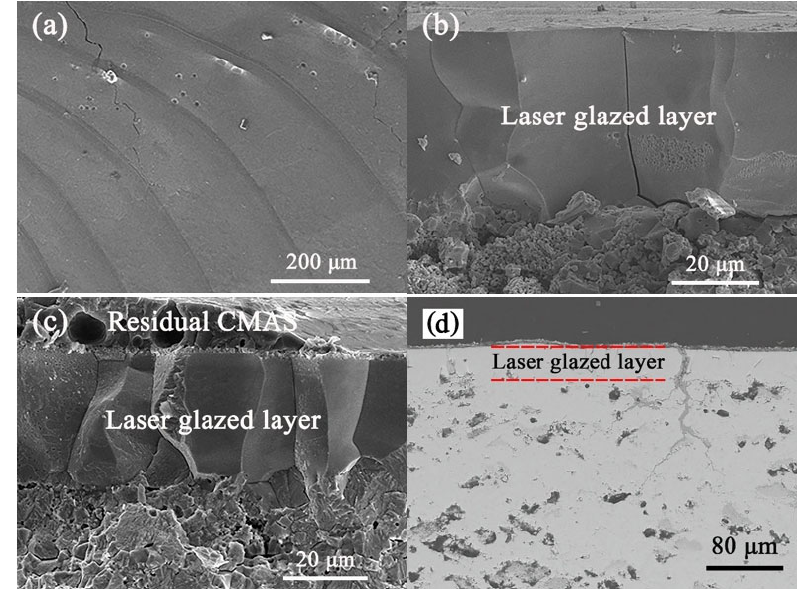
Fig. 56 (a) Surface morphology. (b–d) Cross-sectional microstructures of laser-glazed YSZ TBCs. (c) and (d) are images of the TBCs after corrosion by CMAS and V 2 O 5 , respectively. Reproduced with permission from Ref. [323], © The Author(s)